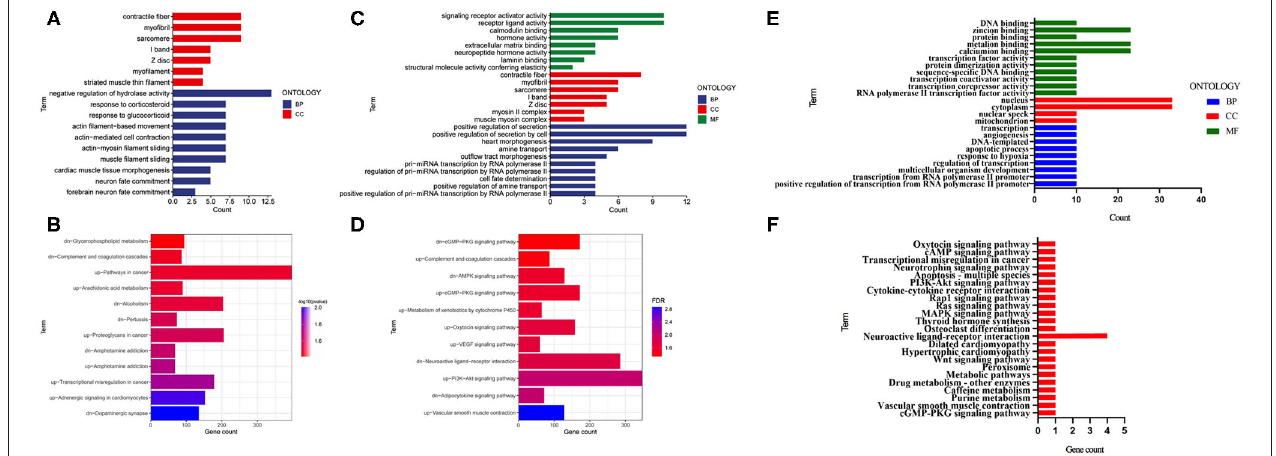
FIGURE 2 | GO and KEGG enrichment analyses were performed for the mRNAs changed after fear memory formation and extinction. (A,B) The DEGs in F and C groups were analyzed by GO and KEGG. (C,D) The DEGs in E and C groups were analyzed by GO and KEGG. (E,F) The commonly changed mRNAs after fear memory formation and extinction were analyzed by GO and KEGG. BP, biological process; CC, cellular component; MF, molecular function; GO, gene oncology; KEGG, Kyoto Encyclopedia of Genes and Genomes; DEGs, differentially expressed